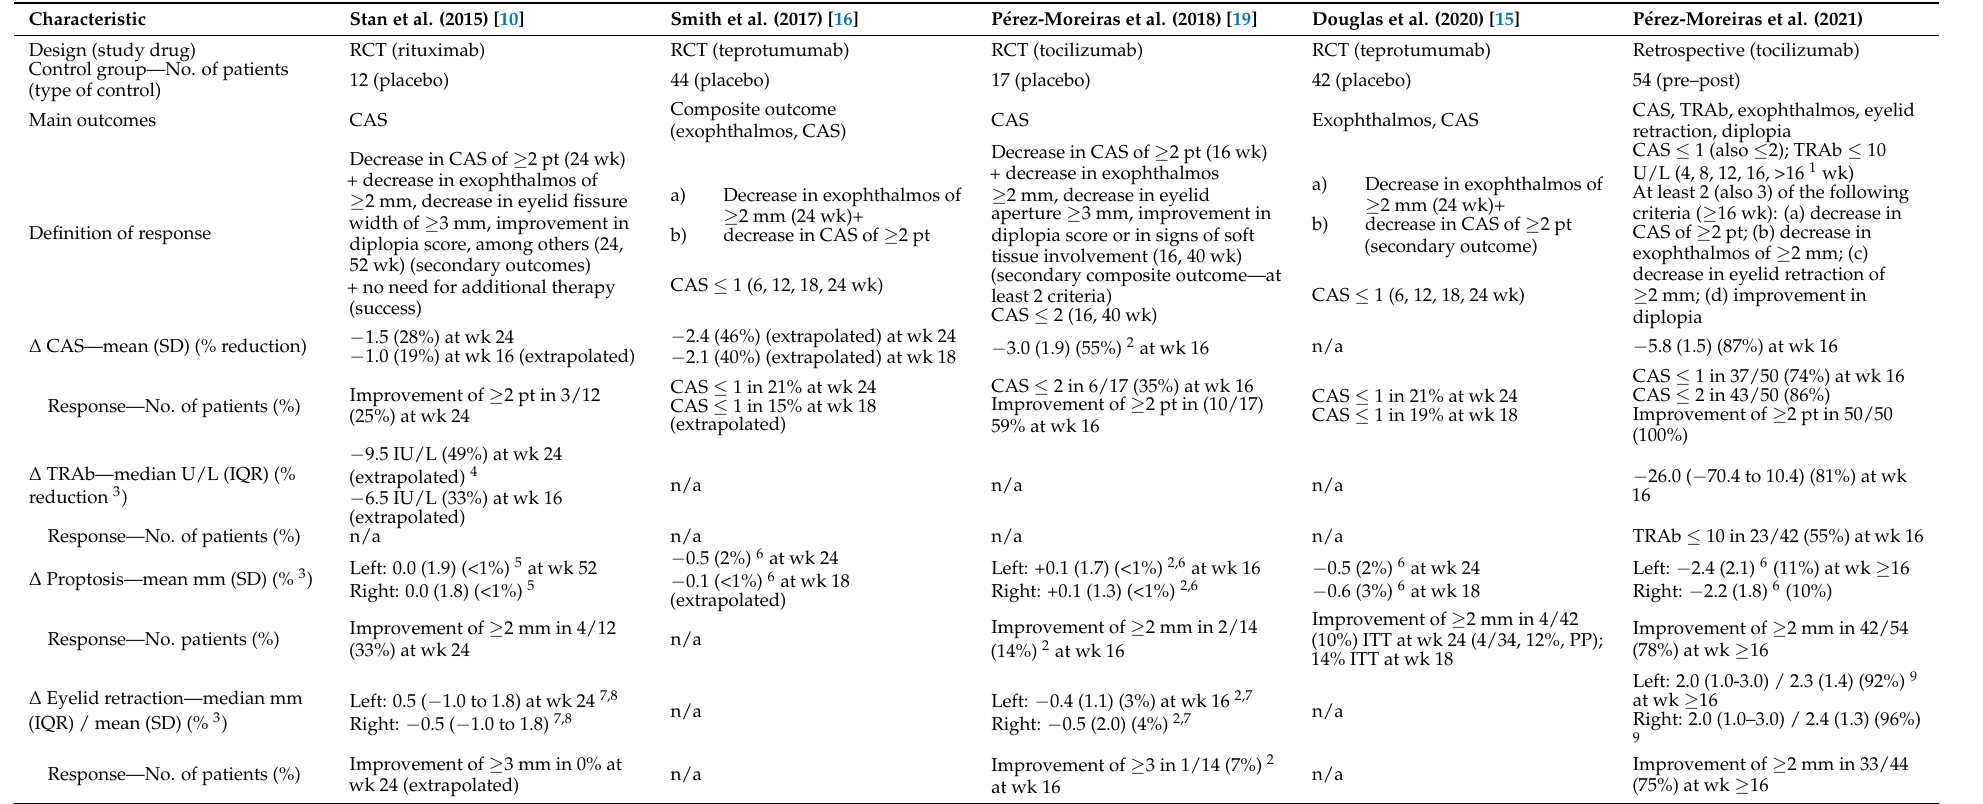
Table 4. Comparison between the results of this study and the placebo groups used in previous clinical trials with monoclonal antibodies in Graves’